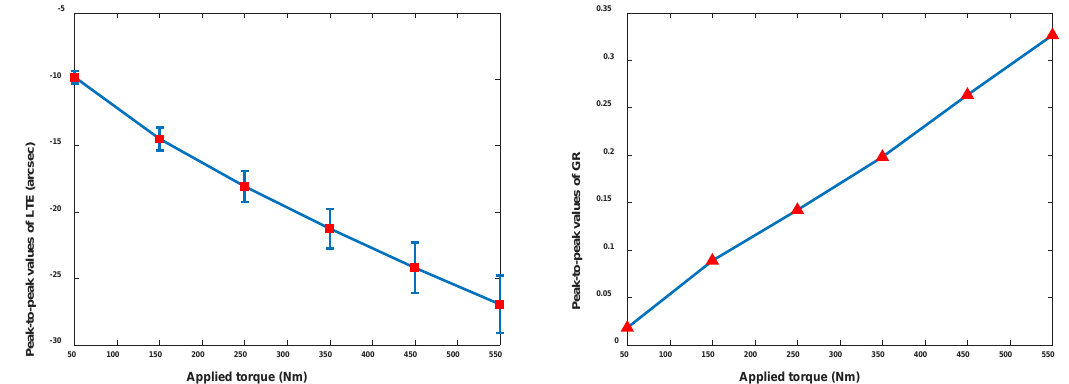
Figure 14. The peak-to-peak values of loaded transmission error (LTE) and gear ratio (GR) under applied torque values of 50, 150, 250, 350, 450, and 550 Nm.